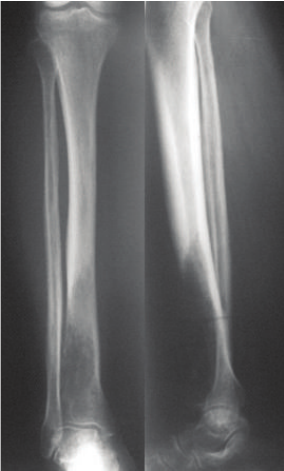
Figure 1: Radiograph showing an osteolytic lesion to the distal third of the tibia with cortical destruction.